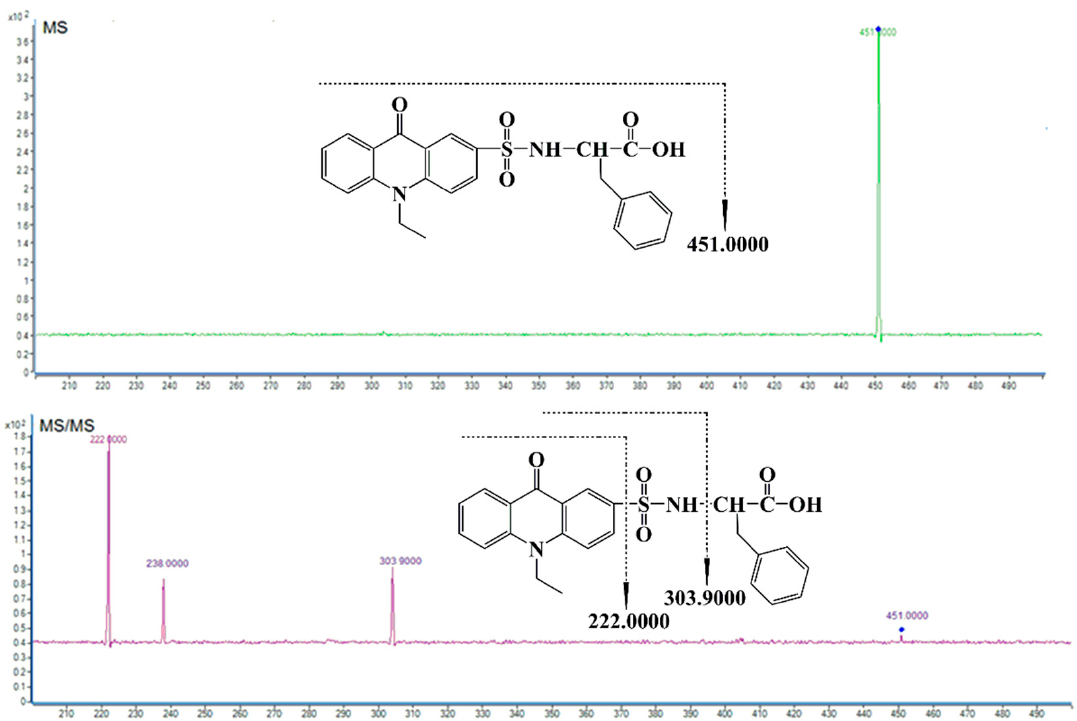
Figure 2. MS spectra of the representative phenylalanine derivative and fragmentation pattern of the protonated molecular ion.